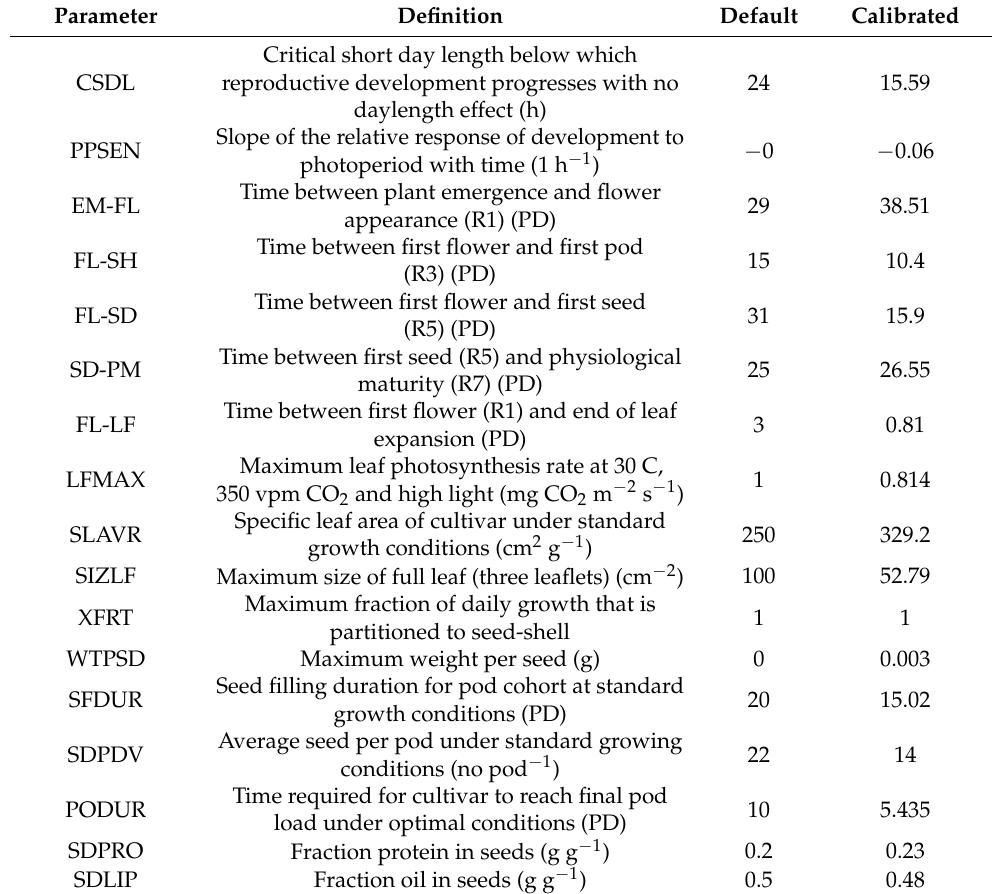
Table 3. Calibrated parameters in CROPGRO-Canola for rapeseed with default values and calibrated values for cultivar